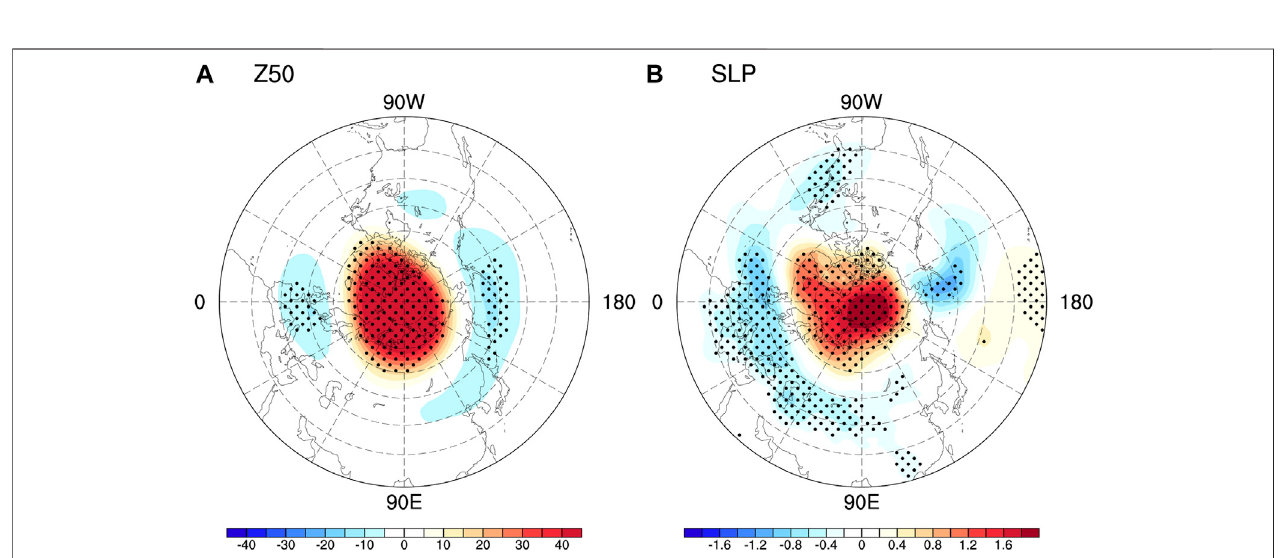
FIGURE9| Regressionsofspring (A) 50 hPageopotentialheight(m) and (B) SLP (hPa)againstthenegative OctoberSNOWI during 1979 – 2017.Stippled regions indicate that the anomalies are signi fi cant at the 90% con fi dence level.